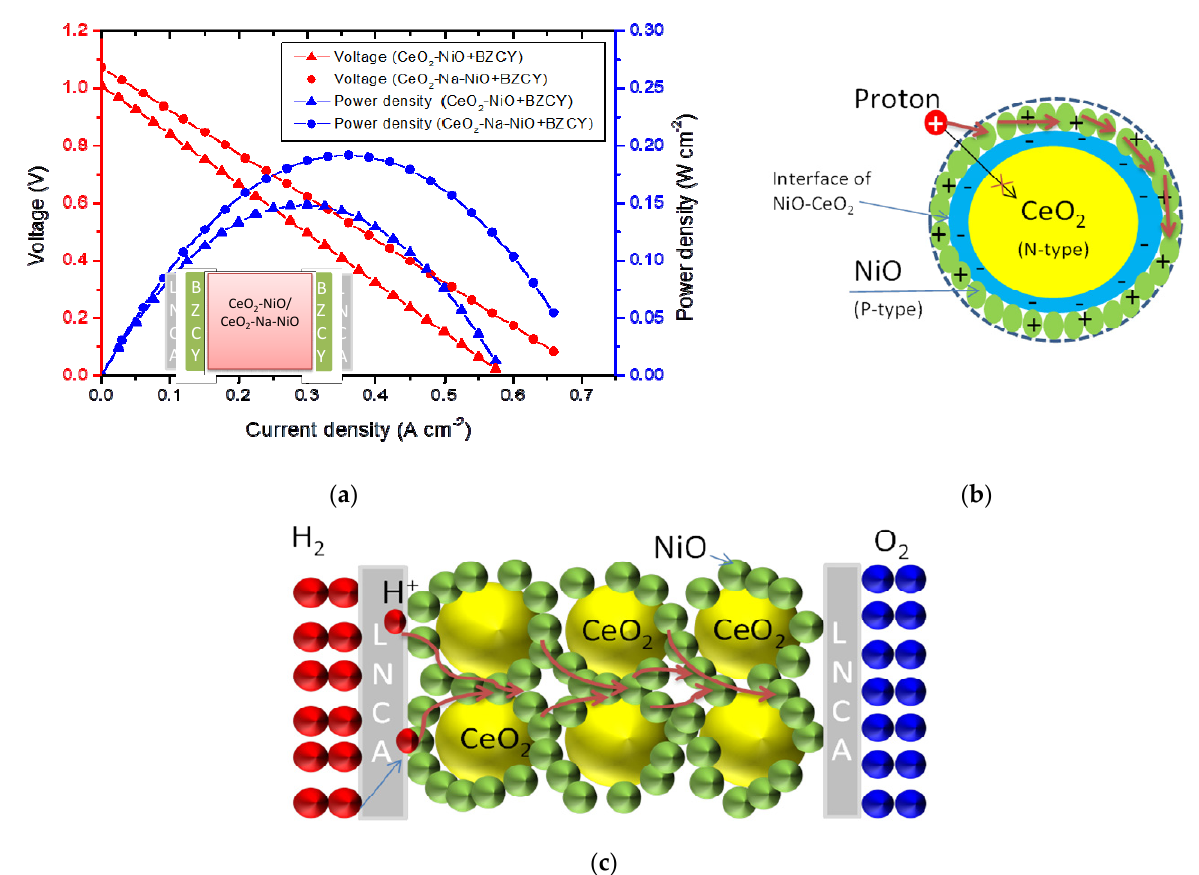
Figure 7. ( a ) Electrochemical performance of the fuel cells with only proton conductivity using BZCY at 530 °C; ( b ) the “proton shuttles” transport in the high-conducting region of the electrolyte membrane constituted by the interface heterostructure of CeO 2 -NiO; ( c ) charge separation at the interface of CeO 2 -NiO particle.